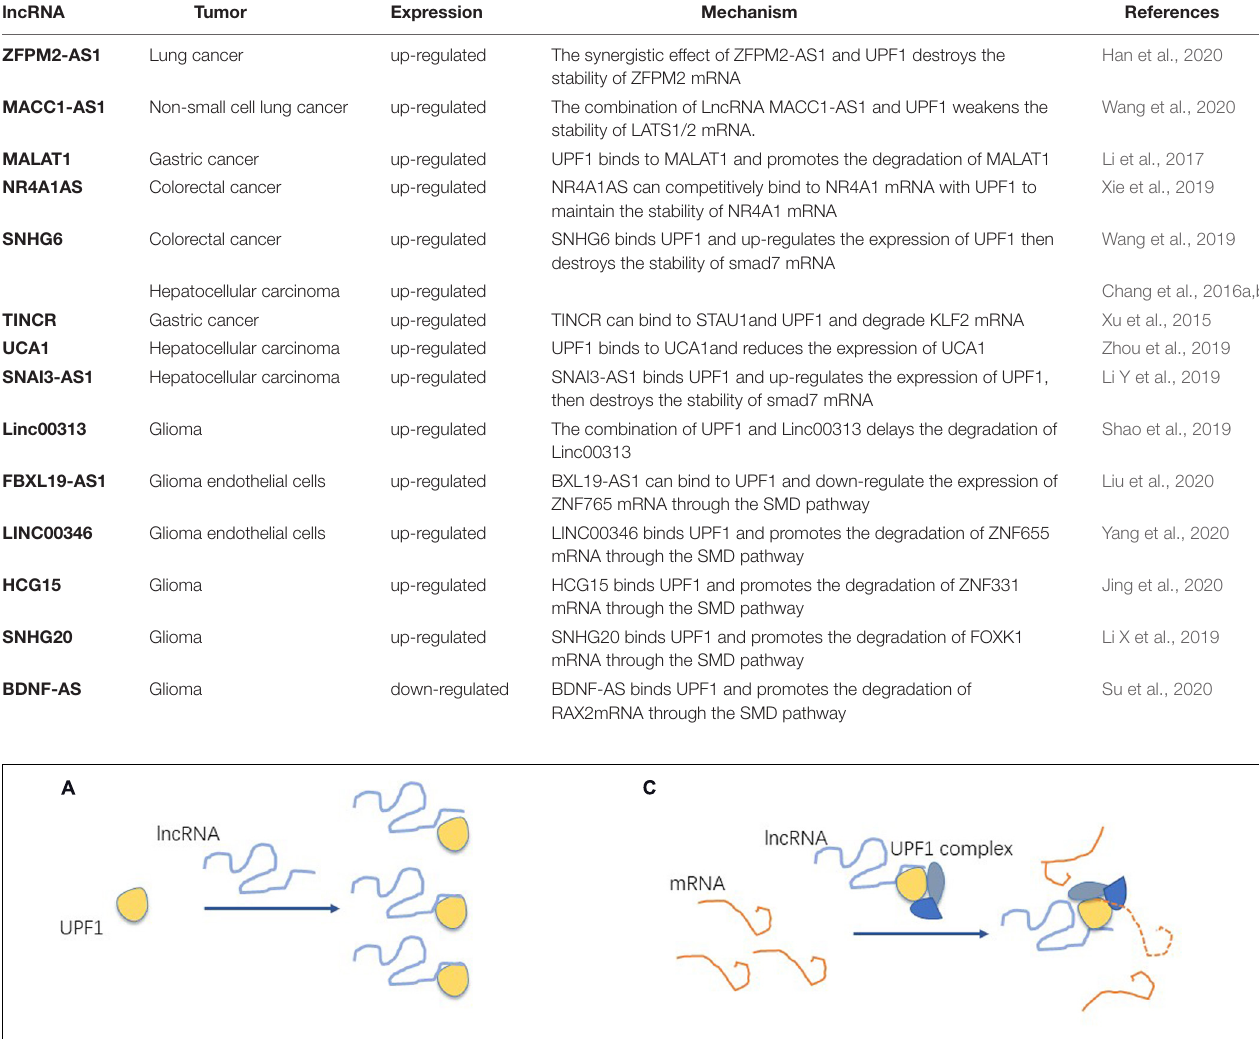
TABLE 1 | LncRNAs mentioned in the review.